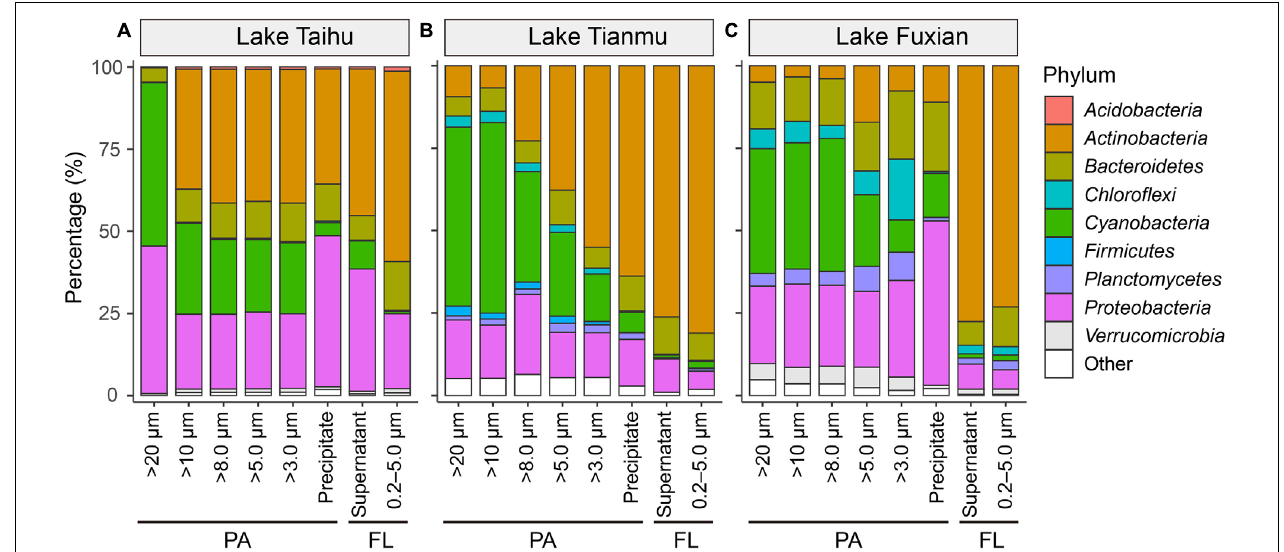
FIGURE 5 | Mean percentage (%) of major bacterial taxa in each treatment at phylum level in (A) Lake Taihu, (B) Lake Tianmu, and (C) Lake Fuxian. The nine most abundant bacterial phyla are shown individually, and minor taxa are combined as “other”. PA, particle-attached; FL, free-living.